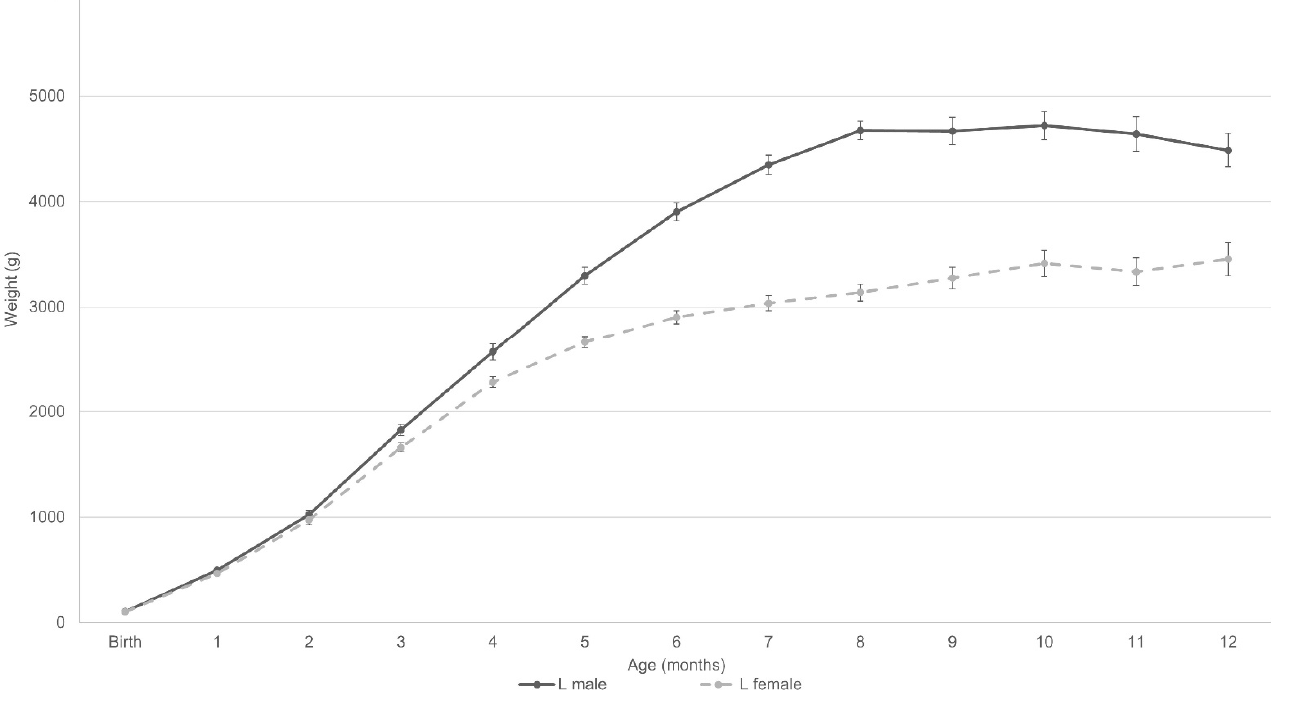
Figure 5. Mean live weight of lean males (L male, n = 30) and lean females (L female, n = 26) from birth until the twelfth month of age. Standard errors are depicted with brackets per month, for both sexes. The illustrated growth curves can cautiously be used as a reference for male and female cats with an expected ideal adult weight at twelve months of 4486 ± 595 g and 3455 ± 614 g respectively.